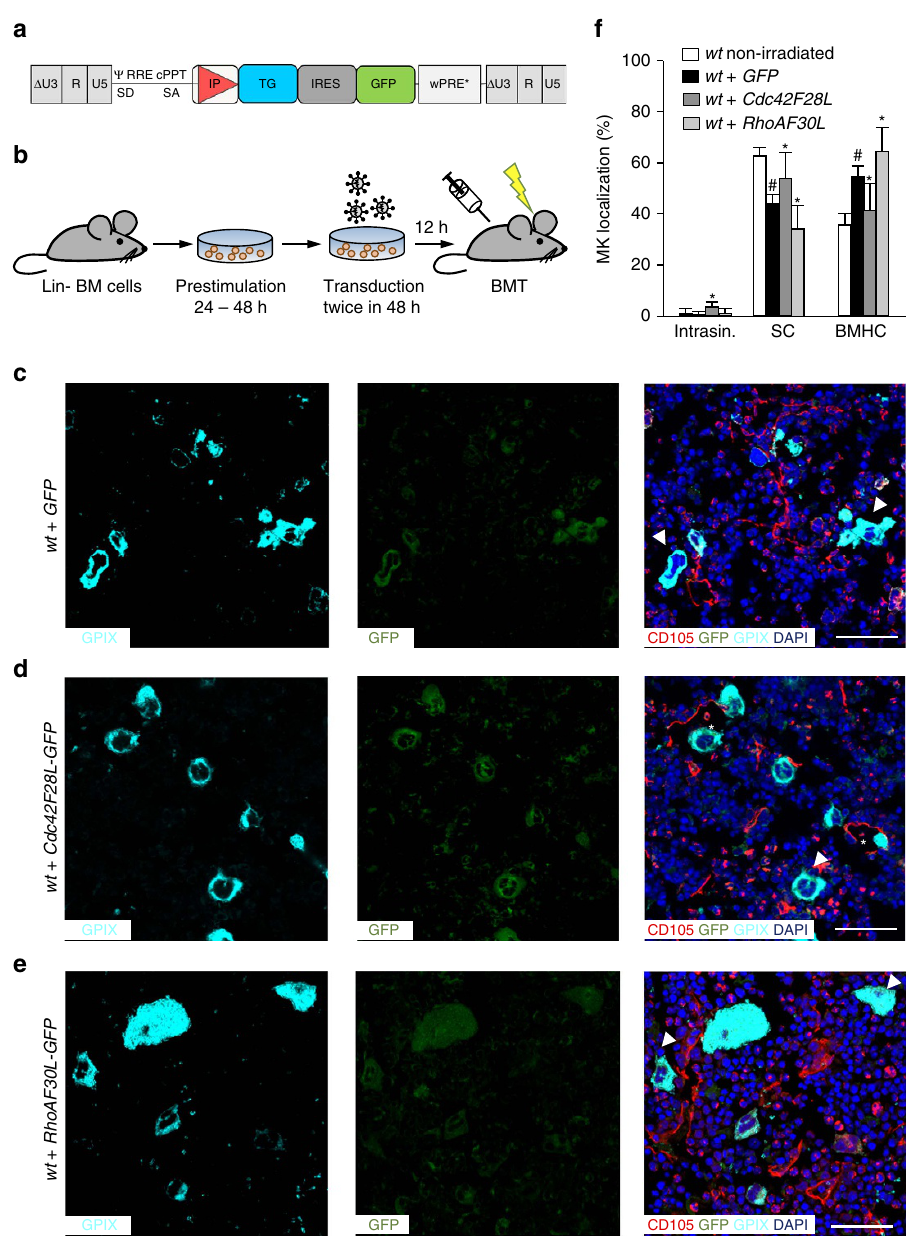
Figure 7 | Activation states of RhoA and Cdc42 have opposing functions in MK localization. ( a ) Third-generation self-inactivating lentiviral vectors were generated, expressing Cdc42F28L and RhoAF30L, respectively, together with GFP through an IRES, or just GFP under control of the MK-specific human GP6 promoter in the internal position. ( b ) Work-flow. Lineage marker-negative (Lin (cid:2) ) BM cells were isolated, pre-stimulated for 24h and transduced twice. Cells were then transplanted into conditioned recipient mice. ( c – e ) Representative confocal images of immunostained BM of wt mice after BM transplantation of wt HSC transduced with GFP ( c ), constitutive active Cdc42 (F28L) ( d ) or constitutive active RhoA (F30L) ( e ). Scale bars, 50 m m. MKs, proplatelets and platelets are shown by GPIX staining in cyan colour. Endoglin staining (red) labels vessels. DAPI, blue. Arrowhead indicates MKs in BMHC, asterisk indicates intrasinusoidal MKs. ( f ) Quantification of MK localization in the BM ( n ¼ 4). Quantification of MK localization in non-irradiated wt mice (white) are shown to demonstrate altered localization after irradiation and transplantation of wt cells. Bar graphs represent mean ± s.d. Two-way ANOVA with Bonferroni correction for multiple comparisons. * P o 0.05, compared to wt þ GFP; # P o 0.05, compared to wt not GPIb-IX-V complex and multiple cytoskeletal proteins including A is required for proper localization of either protein 45 . Filamin A, non-muscle myosin IIa (NMM-IIa), b -tubulin, Deficiency of Filamin A in MKs was shown to affect DMS a -actinin and Diaphanous Related Formin 1 (DIAPH1) that formation 46 and results in premature release of large, fragile control the late stages of MK maturation with defects in platelets in humans and mice 47,48 . Together with the observation that polarity in osteoclasts depends on a network involving both individual proteins all giving rise to macrothrombocytopenia 40,44 . Interaction of the cytoplasmic domain of GPIb a with Filamin A Filamin A and Cdc42 (ref. 49) this points to a critical role of provides a major link between the receptor and the MK Filamin A for the transmission of signalling between GPIb a cytoskeleton and coordinated expression of GPIb a and Filamin and Cdc42.